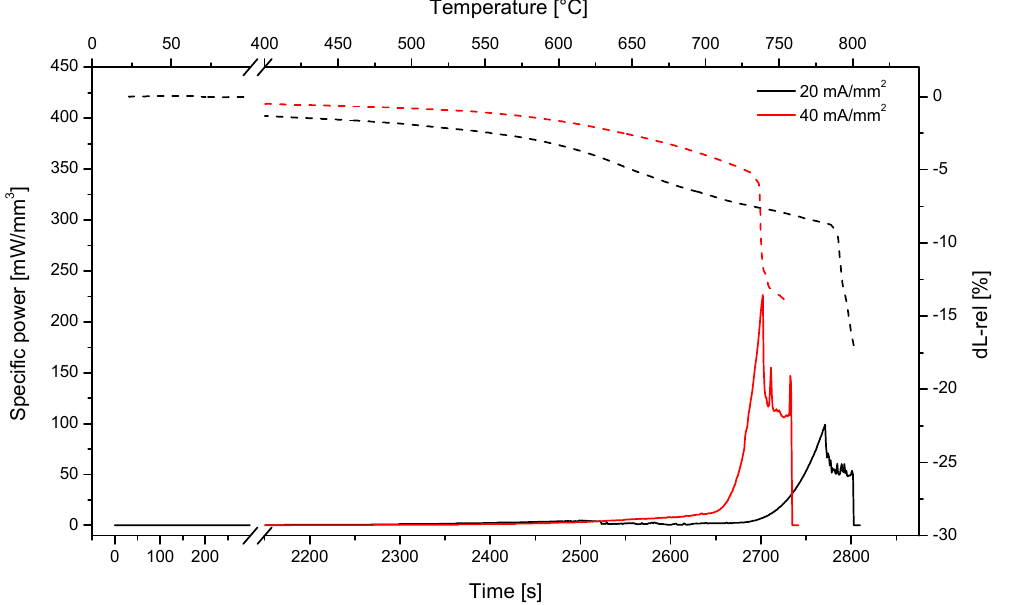
Figure 8. Specific power density and dilatometric plot for SPDC-NH3 samples treated using 50 V / cm and different current limits.